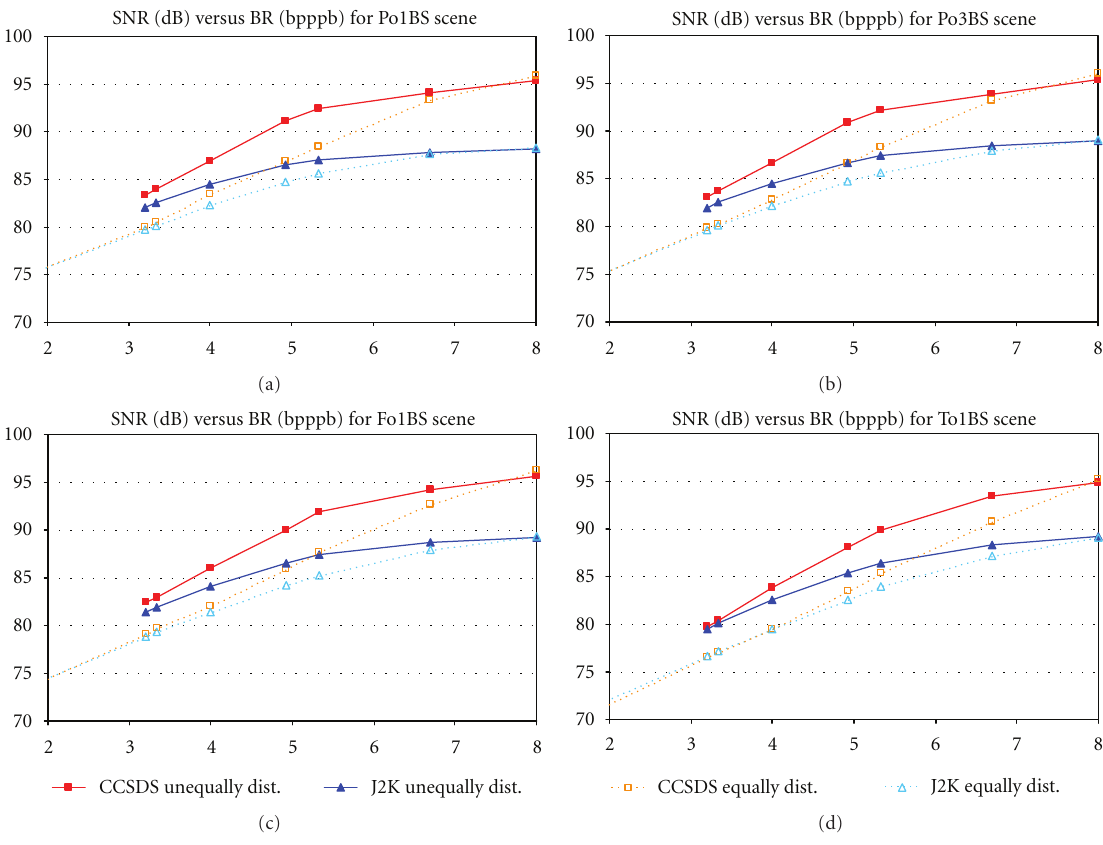
Figure 4: SNR (in dB) in relation to the bit rate (in bpppb) of CCSDS and JPEG 2000 for all scenes at high bit rates. Two strategies were used to split BR among bands (at each compression ratio): unequally or equally distributed. (Please note that the y -axis is not the same as in Figures 5 and 6.) Table 2: SNR (in dB) in relation to the bit rate (in bpppb) of CCSDS and JPEG 2000 for all scenes at low bit rates. Only the equally distributed BR among bands was studied at these compression